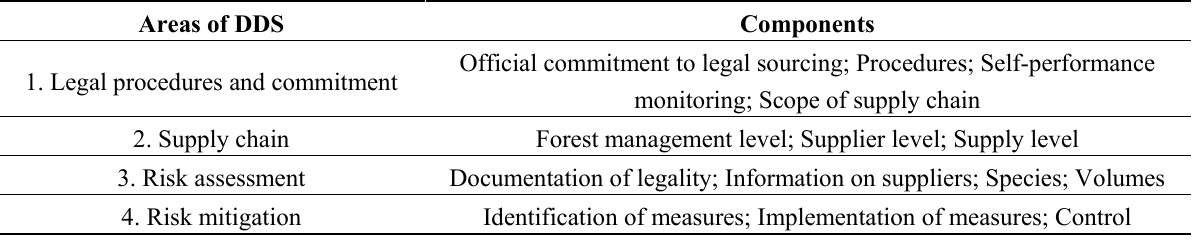
Table 2. The key areas of the company’s DDS and its components.